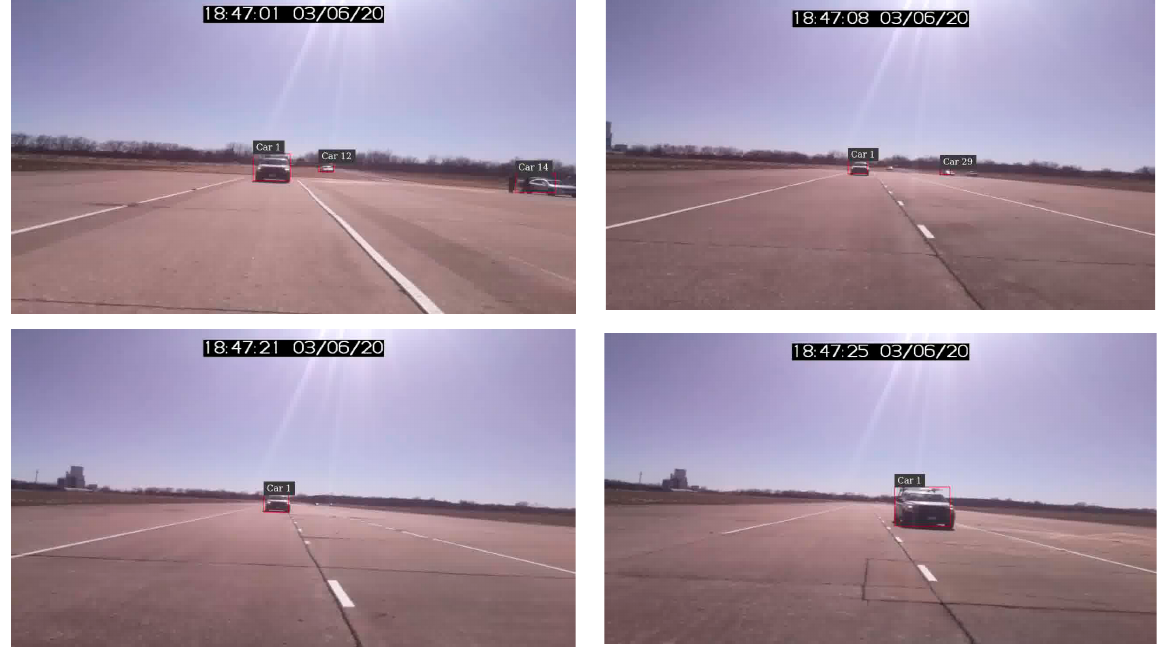
Figure 3. A sample of DeepStream vehicle detection.